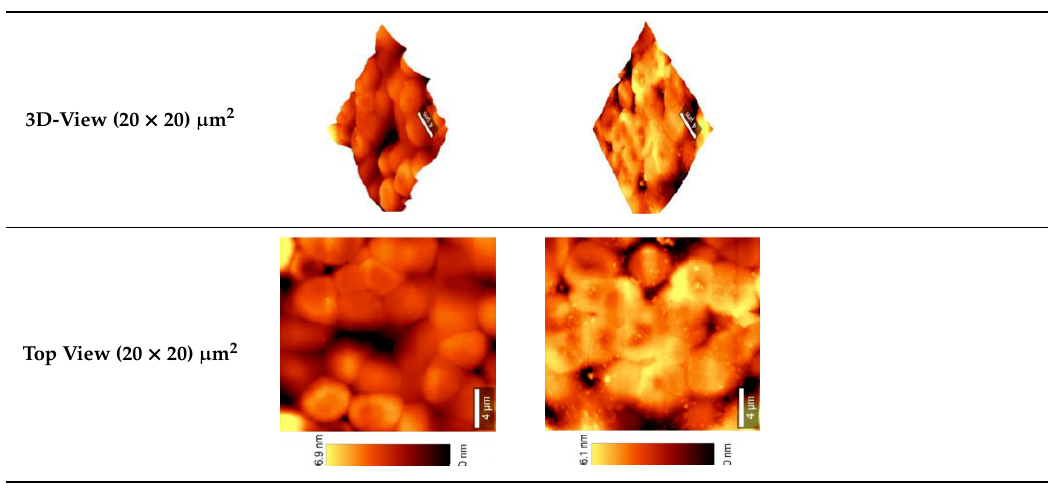
Table 4. Atomic force microscopy (AFM) measurements at surfaces of PHBV film blended triethyl citrate (TEC), constant melt flow rate (MFR) during extrusion.